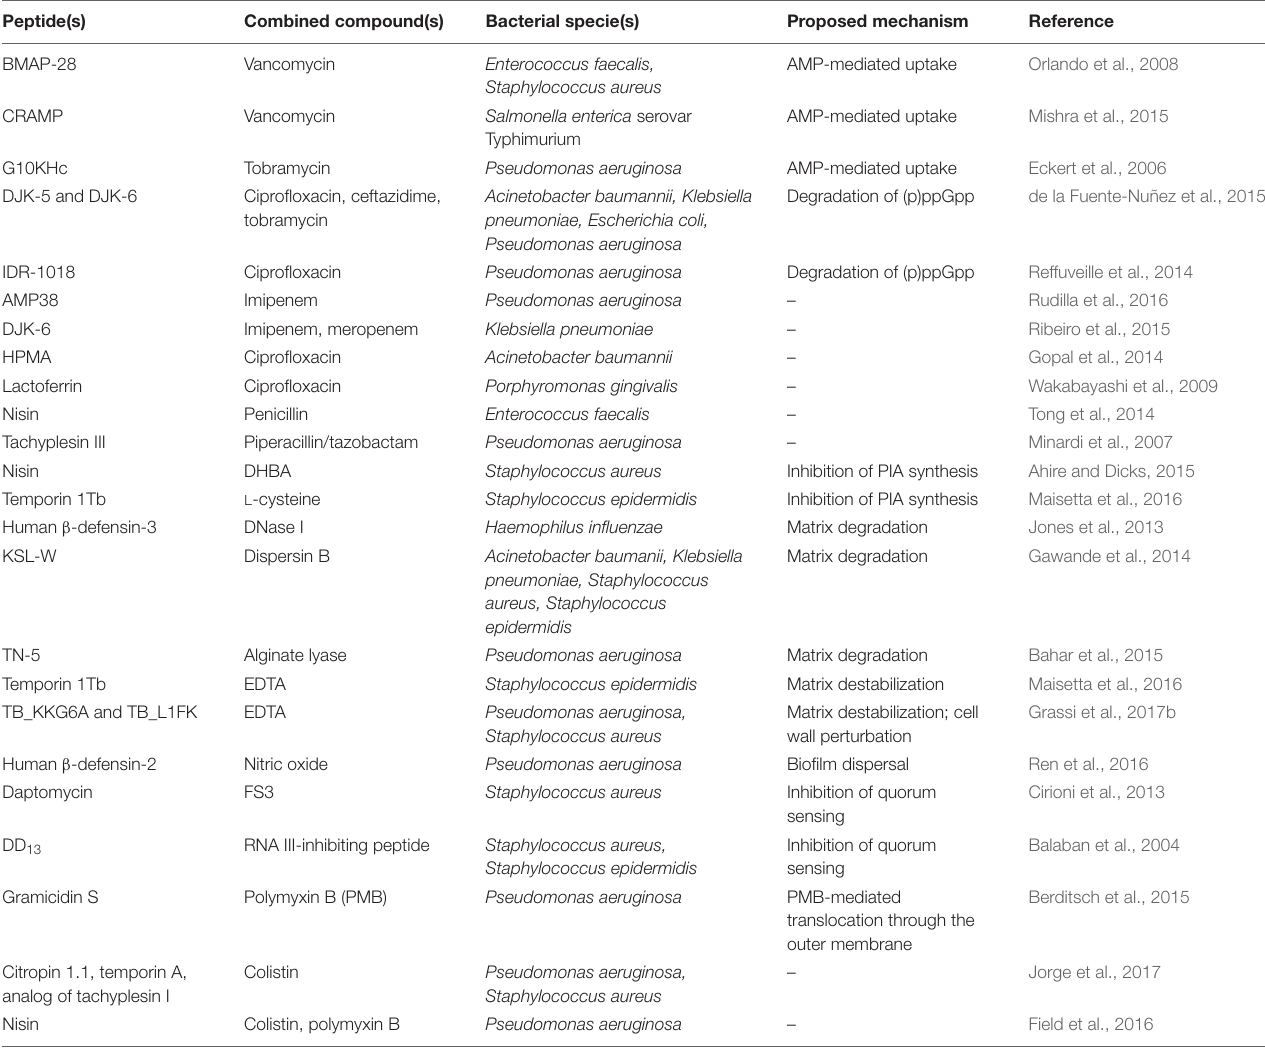
TABLE 1 | Antibiofilm combination strategies involving AMPs or peptide-based